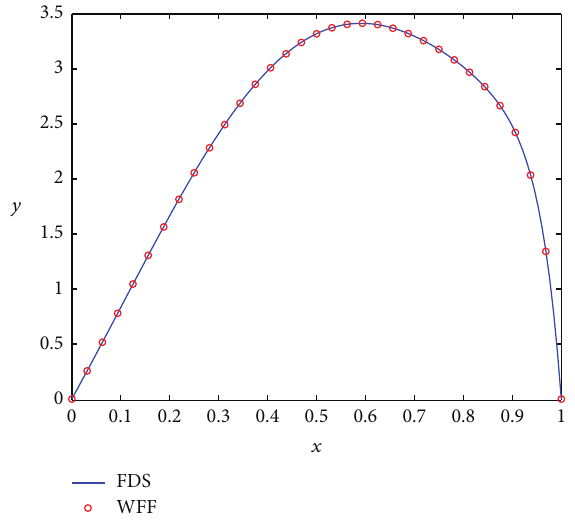
Figure 7: Solution of the BVP: using windowed Fourier frames and using a standard finite difference